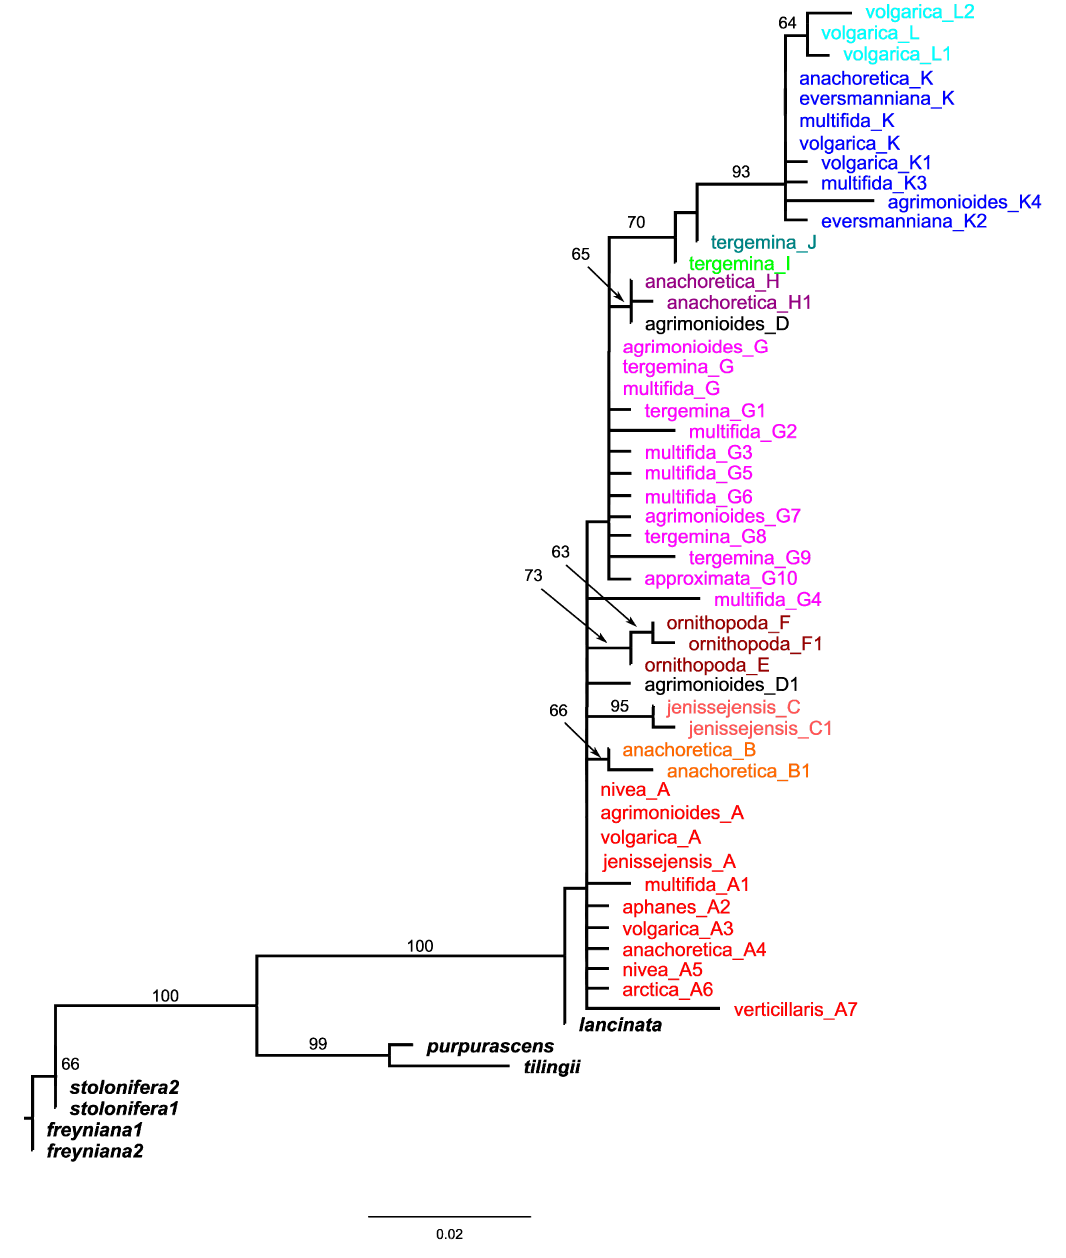
Figure 1. Maximum likelihood tree of Potentilla multifida agg. based on plastid genomic markers. Terminal names within the ingroup are followed by corresponding haplotype designations. Bootstrap support higher than 50% is indicated above branches. Different haplotype groups are highlighted with colors corresponding to those in Figure 2.